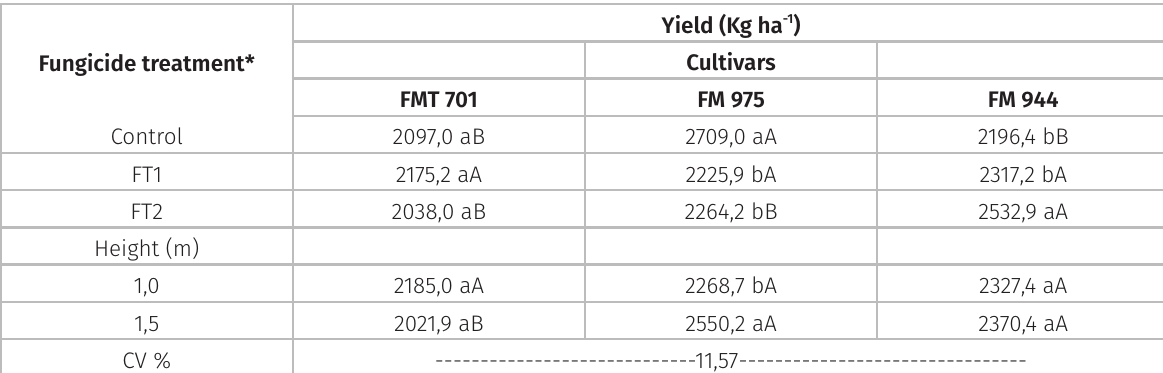
Table VIII. Cotton seed yield (kg ha -1 ) in the lower portion of the plant of three cultivars, submitted to two plant heights and three fungicide treatments in cotton. Chapadão do Sul, MS. Crop season: